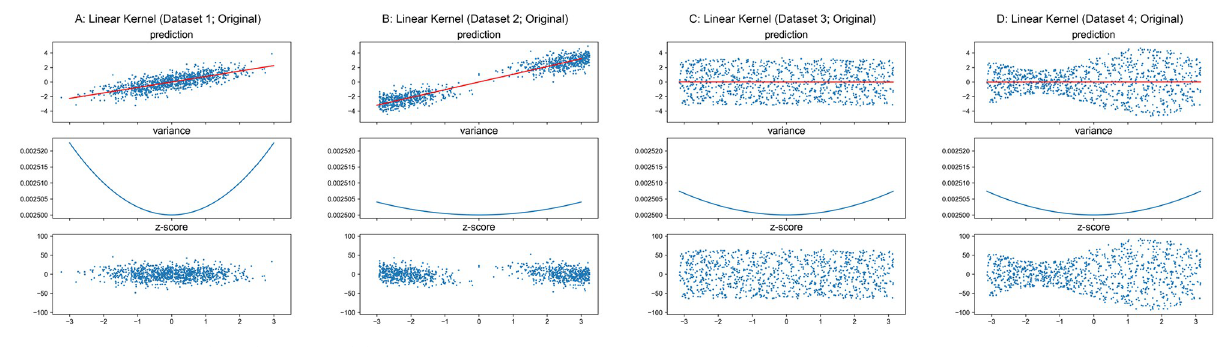
Fig 4. GPR with linear kernel on original datasets.